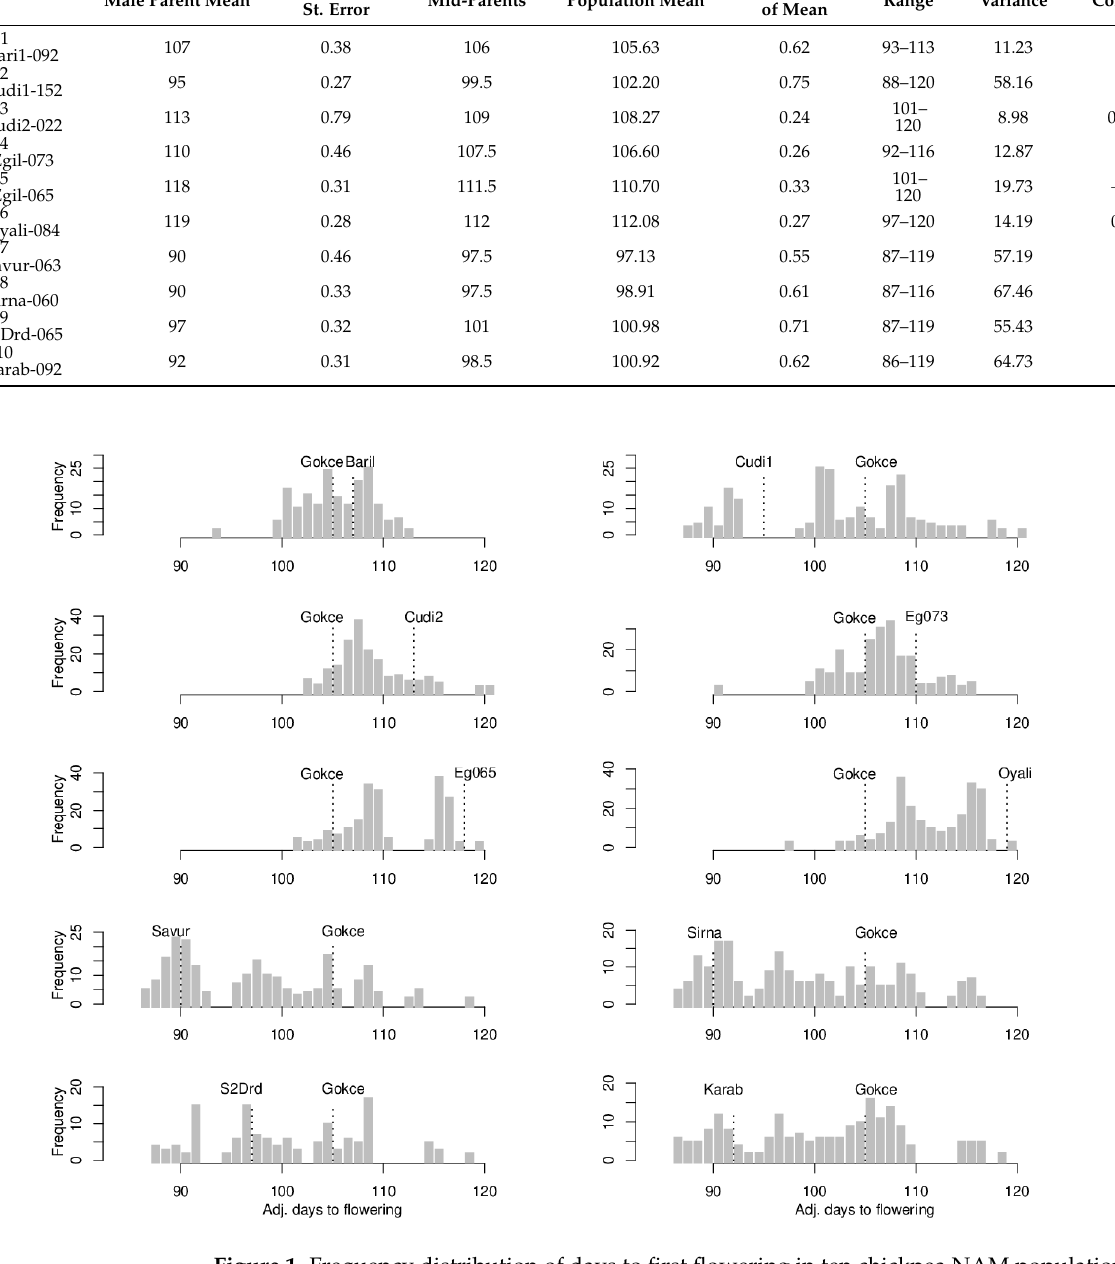
Figure 1. Frequency distribution of days to first flowering in ten chickpea NAM populations. Grey bars show the distribution of progeny values. Parental values are indicated with vertical dotted lines and